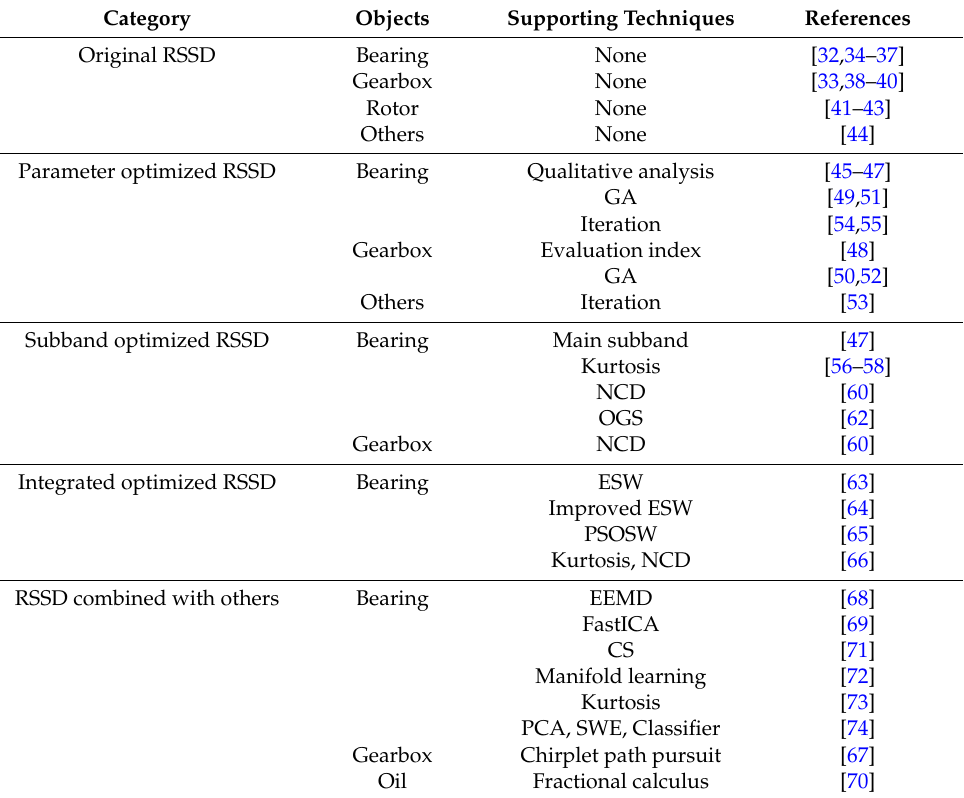
Figure 19. Flow chart of RSSD in mechanical fault diagnosis. Table 4. Summary of RSSD applications in mechanical fault diagnosis.